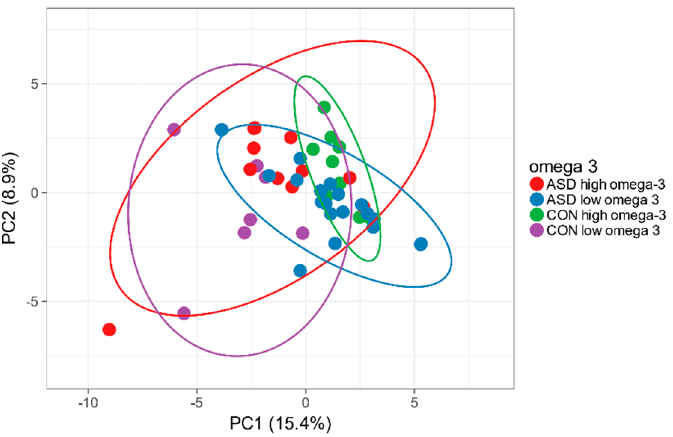
Figure 10. Intestinal microbiota in children with and without ASD with high and low omega-3 daily intake, significantly differently abundant genera.